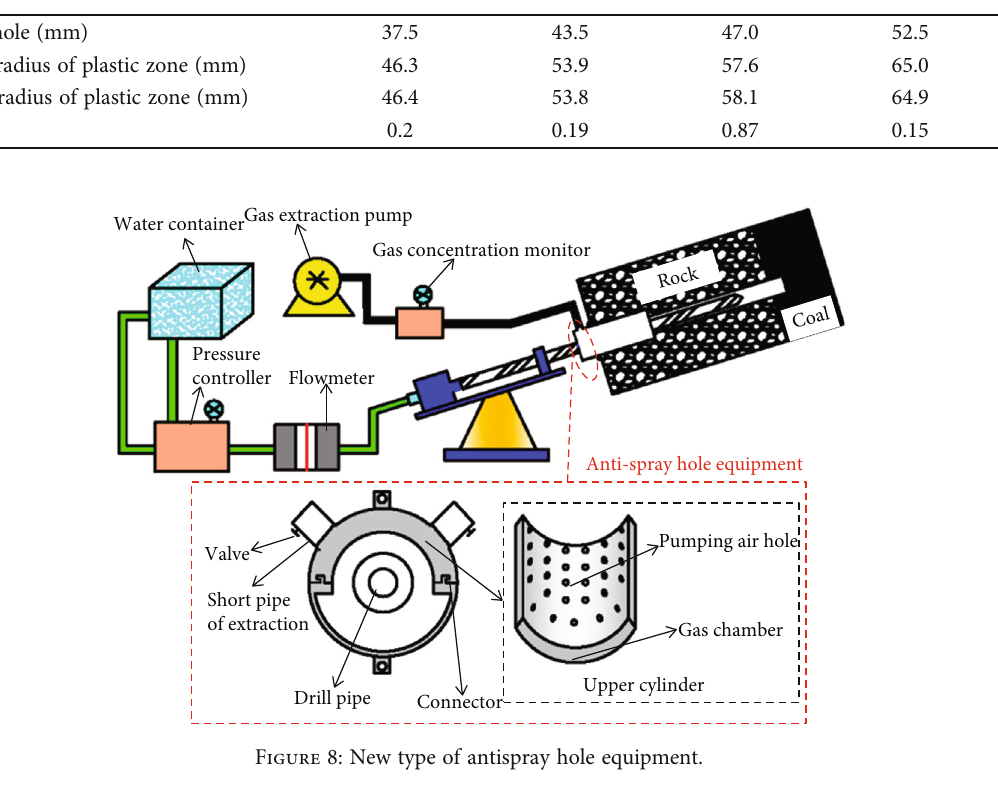
Table 4: Comparison of the radius of the plastic